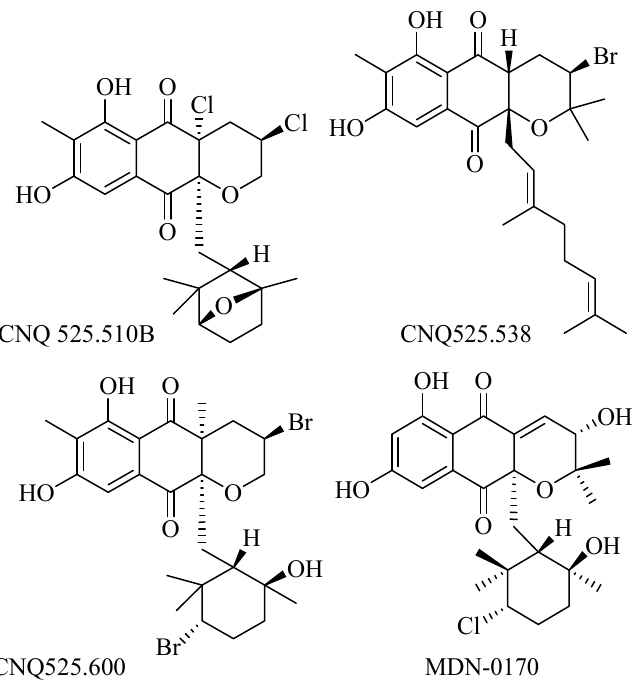
Figure 3. Halogenated terpene and monoterpene.